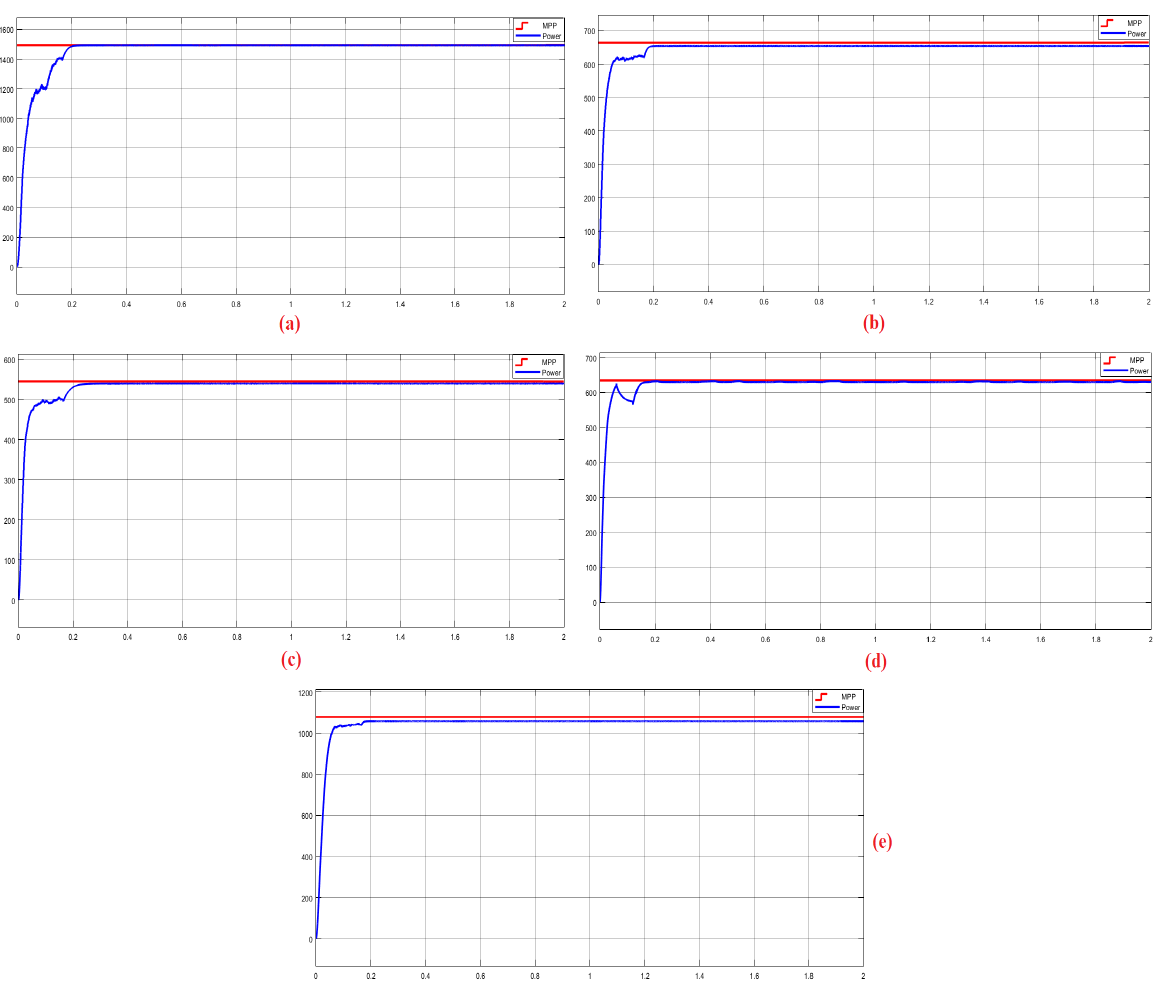
Figure 14. The power–time graph of GWO under different shading conditions. ( a ) For the UIC graph; ( b ) For the second CPSC graph; ( c ) For the third CPSC graph; ( d ) For the fourth CPSC graph; ( e ) For the fifth CPSC graph.